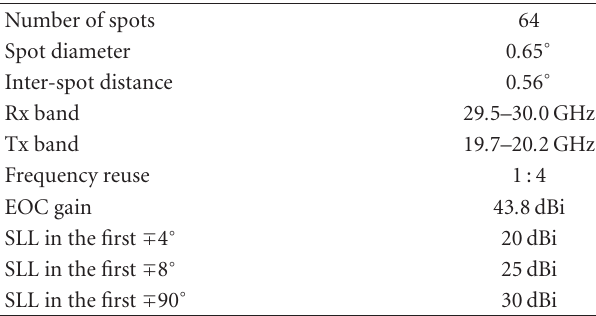
Table 1: Mission